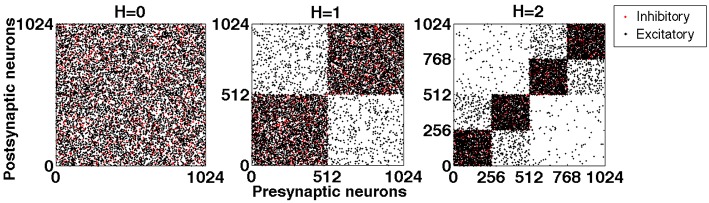
Exemplary connection matrices for networks with hierarchical levels H = 0, 1, and 2, constructed by the top-down procedure. Black dots: excitatory connections. Red dots: inhibitory connections. Note that the latter never interconnect different modules.